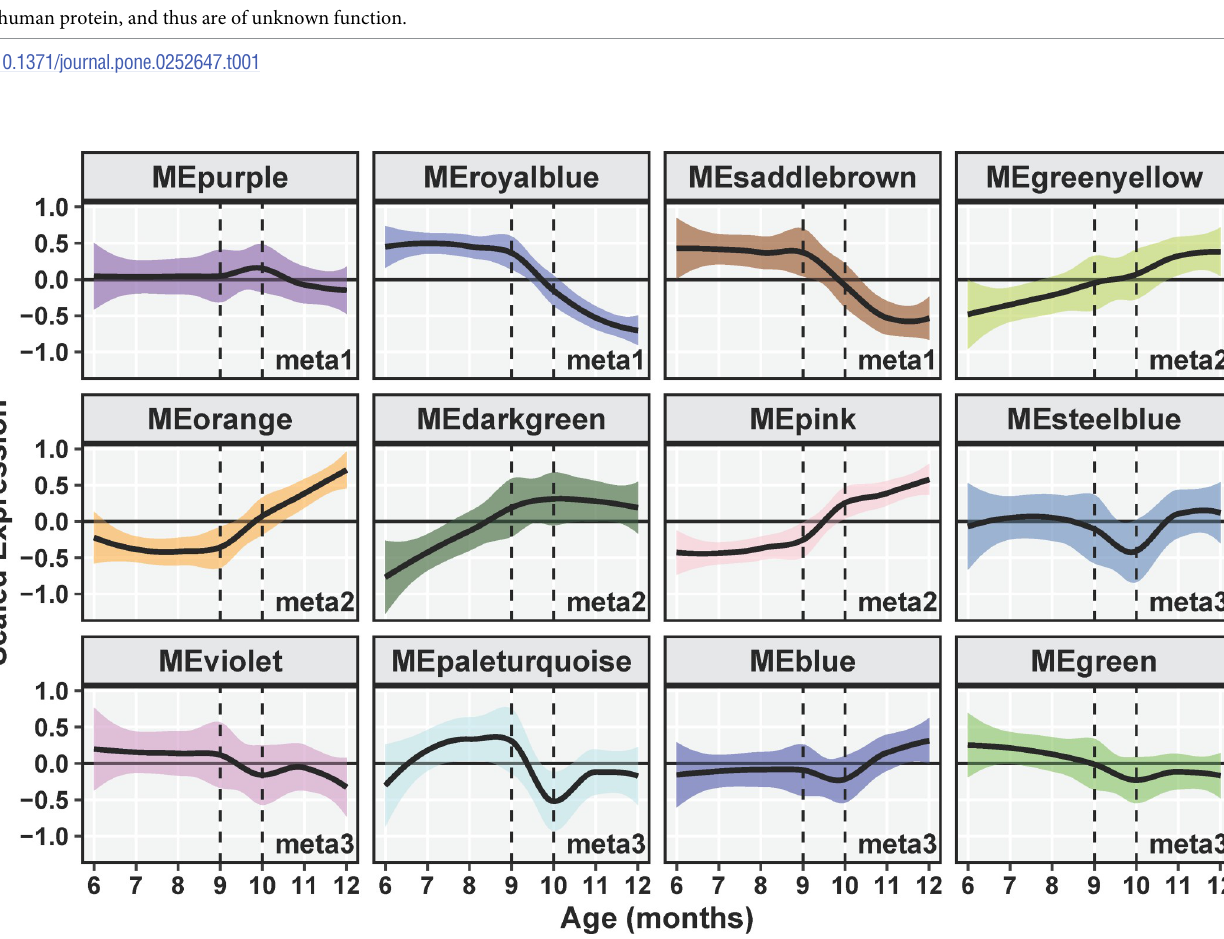
Fig 2. Expression trajectories of consensus co-expression module eigengenes of Aplysia californica sensory neurons over the adult lifespan. Each cell represents the mean centered and variance scaled expression of a module eigengene, with the solid line the monthly average with colored bounding area representing the standard error. Dotted lines highlight the transition at age 9–10 months, during which most module eigengenes exhibit perturbations of their expression